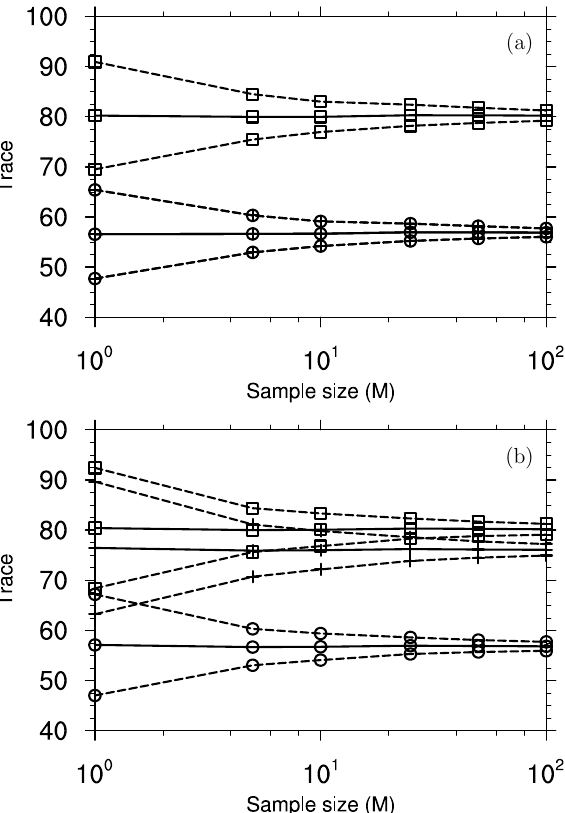
Fig. 4. Randomized trace estimation of Tr ( HK ) ( a , squares), Tr [ ( HK ) 2 ] ( a , circles), Tr [ ( HK ) T HK ] ( a , plus signs) and Tr ( KH ) ( b , squares), Tr [ ( KH ) 2 ] ( b , circles), Tr [ ( KH ) T KH ] ( b , plus signs), as a function of the ensemble size used for the randomization. Solid line: expectation; dashed lines: expectation plus or minus one stan- dard deviation, as determined from a Monte-Carlo approach with 200 independent